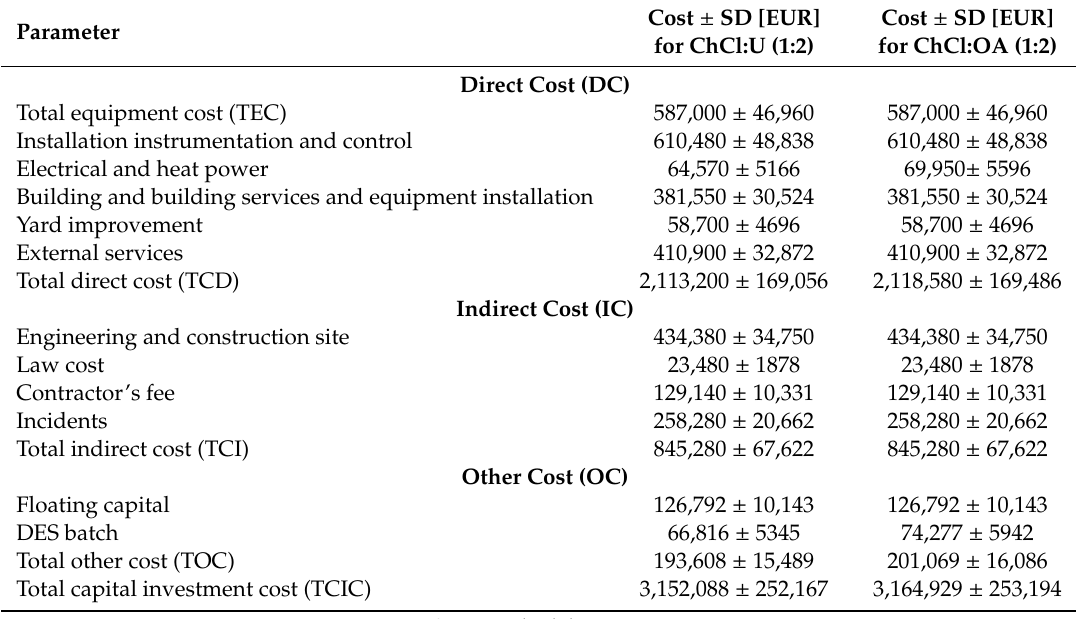
Table 7. The general estimate the total capital investment cost ( TCIC ) for DES.